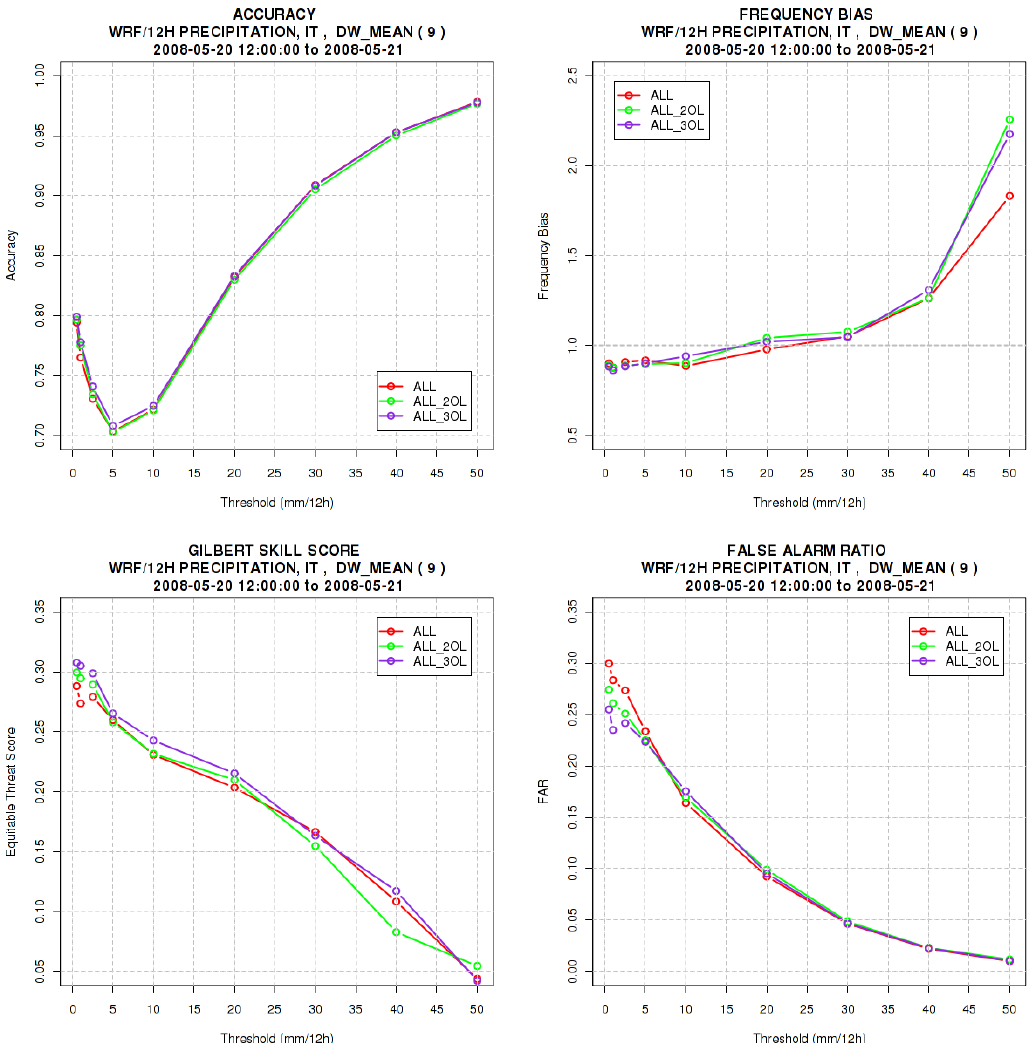
Figure 13. Outer loop sensitivity: ACC, FBIAS, ETS and FAR for ALL, ALL_2OL and ALL_3OL. The red line refers to one loop, the green line to two loops, and the violet line to three